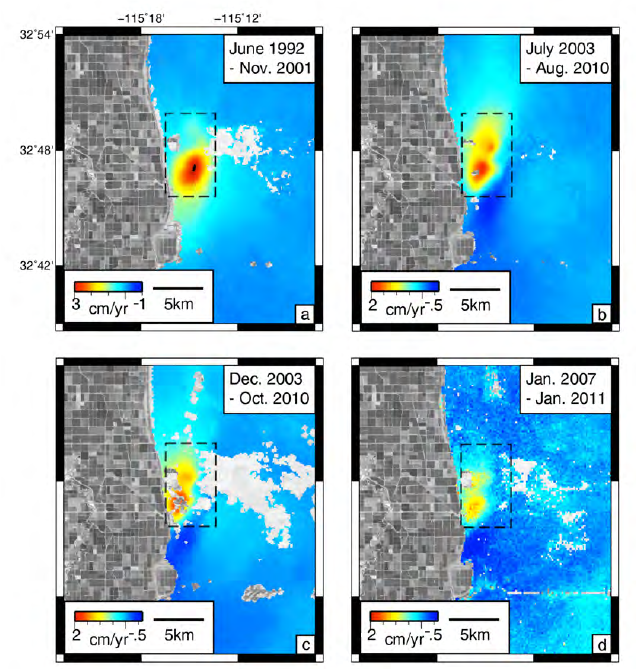
Figure 7. A grayscale Landsat image overlaid with the average LOS velocity (negative values moving toward the satellite) for ( a ) ERS track 84, ( b ) Envisat track 84, ( c ) Envisat track 306, ( d ) and ALOS-1 path 211. The dashed box indicates the extent of the well field (Figure